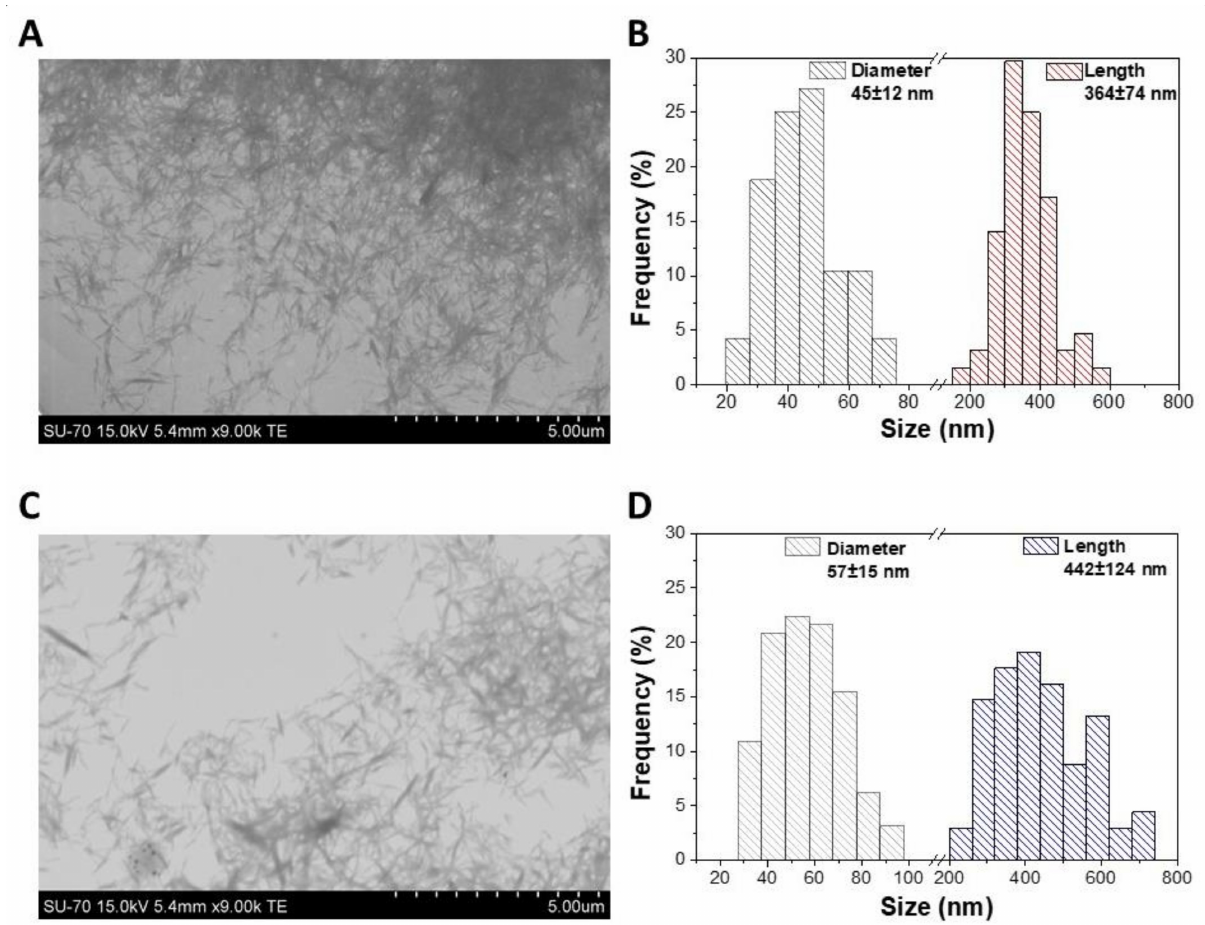
Figure 3. STEM micrographs ( A , C ) with the corresponding size histograms (diameter and length, ( B , D )) of the ( A , B ) pristine CNCs and ( C , D ) CNCs/FA-CS-FITC_3